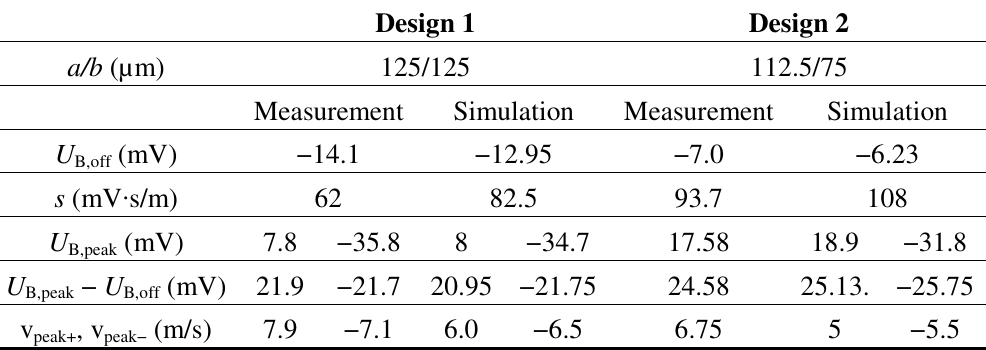
Figure 10. Measured fluid temperature during the measurement runs for the two flow transduction characteristics. Table 1. Sensor specifications for designs 1 and